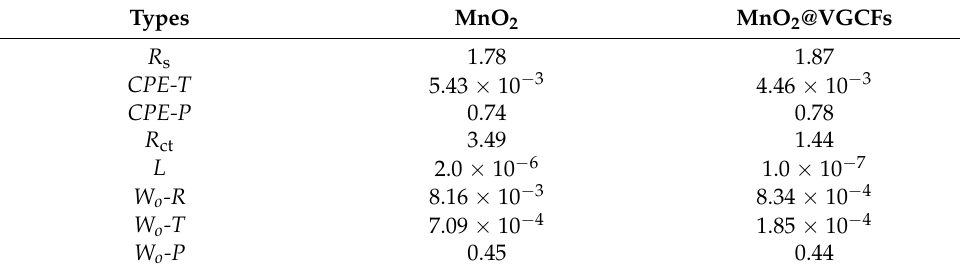
Table 1. Fitting results of the electrochemical